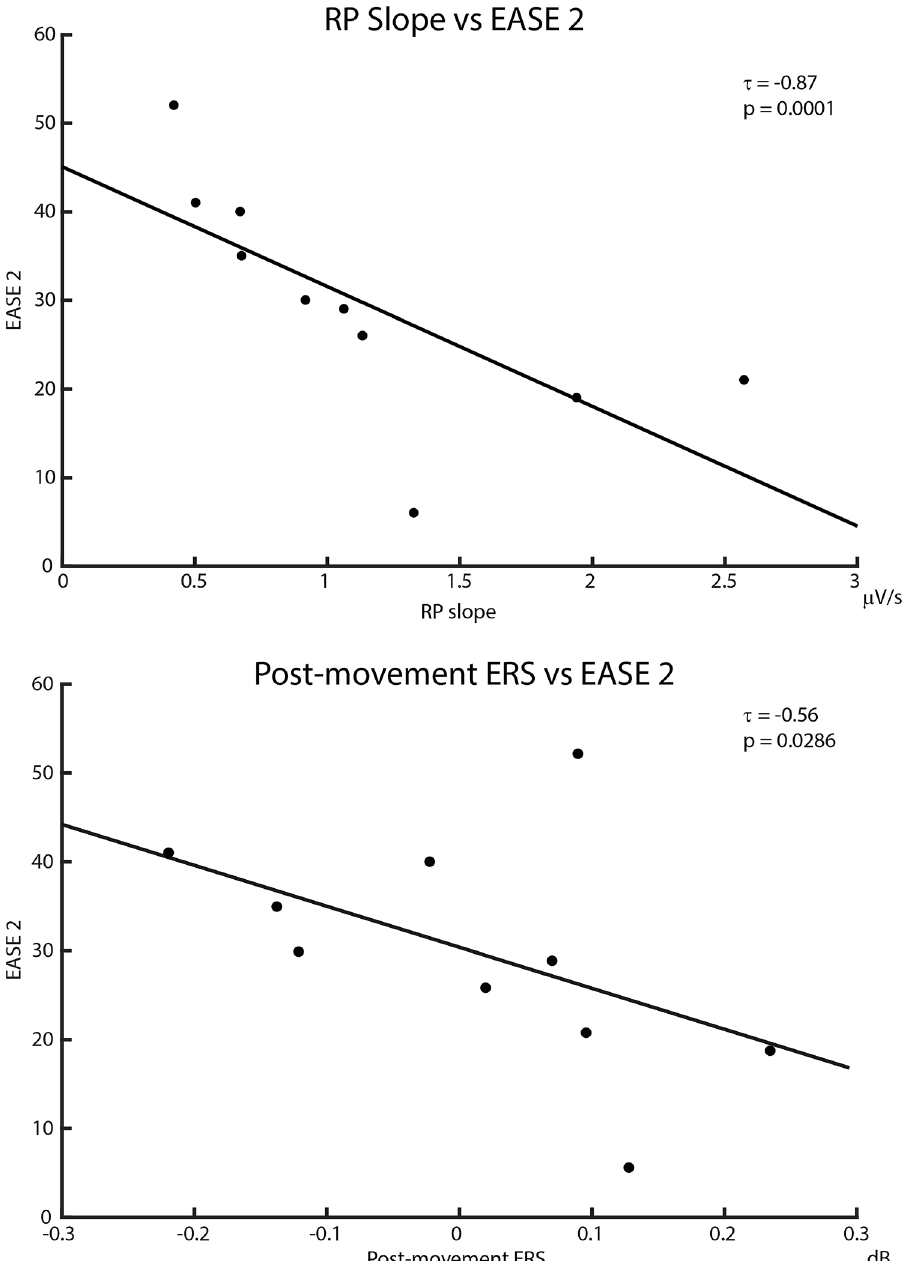
Figure 3. Smaller Readiness Potential (RP) and weaker post-movement Event-Related Synchronization (ERS) are associated with disturbances of self-awareness. Figure shows correlations between movement-related electroencephalographic parameters (i.e. RP and ERS) and abnormalities of self-awareness as quantified by the Examination of Anomalous Self-Experience (EASE, item 2). RP slope (top) and ERS (bottom) correlated negatively with EASE-2 scores. Correlation coefficients (Kendall’s tau, τ) and significance ( p -values) are